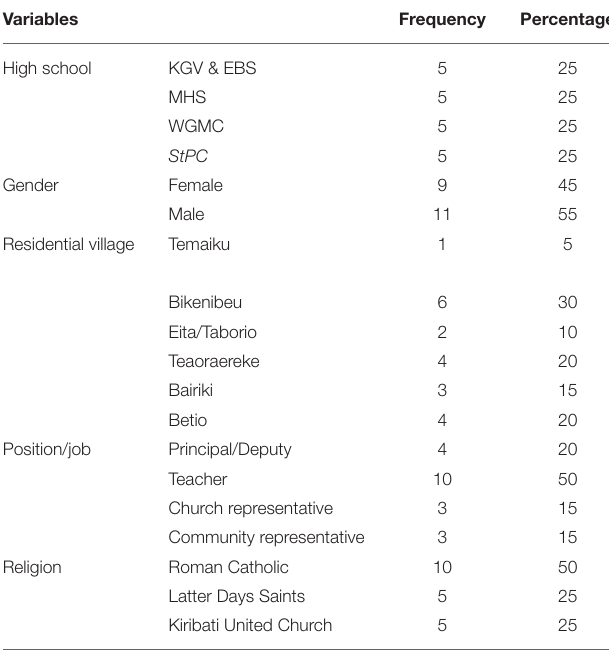
TABLE 1 | General characteristics of SCMs ( N = 20).